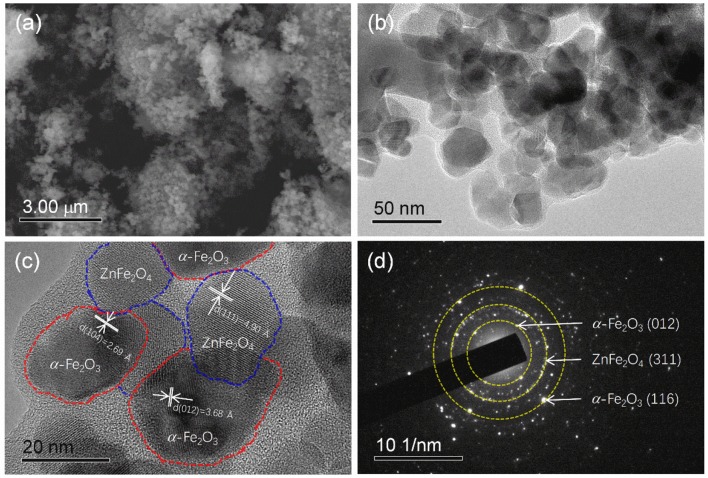
(a) SEM image, (b,c) STEM imanges, and (d) SAED pattern of the as-prepared ZnFe2O4/α-Fe2O3 nanocomposites.